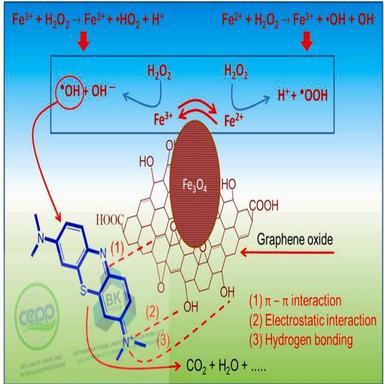
Adsorption and catalysis mechanism of FG2I for MB.